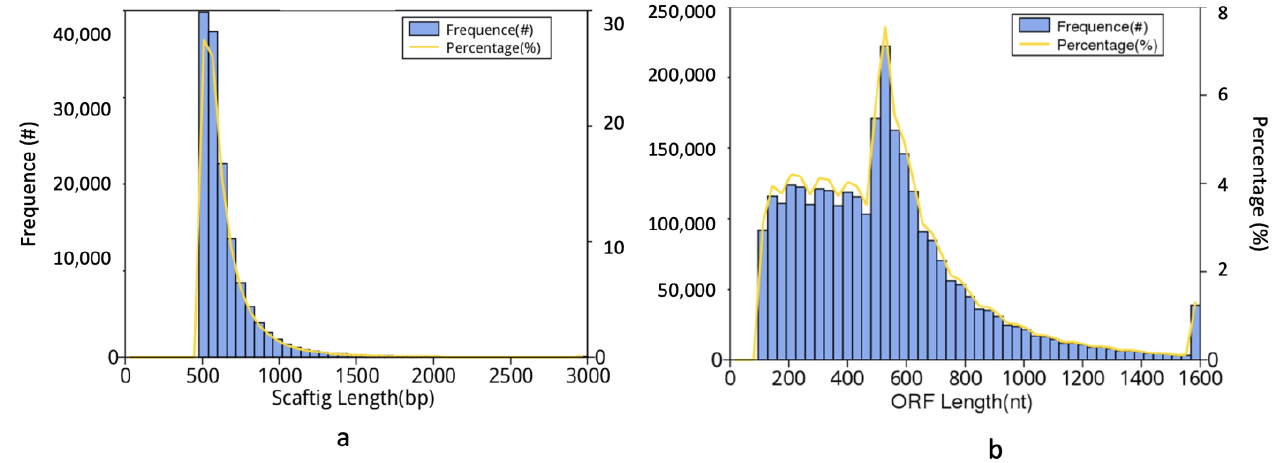
Figure 2. ( a ) Scaftig length distribution; scaftigs > 500 bp were used for open reading frame (ORF) prediction. ( b ) ORF length distribution plot. The ORFs < 100 nt were removed.